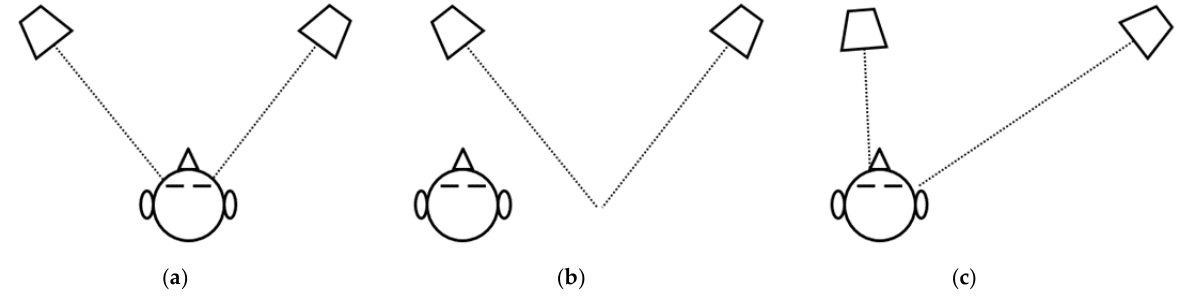
Figure 5. Listening positions: ( a ) ideal situation, ( b ) nonideal situation, and ( c ) modified situation.